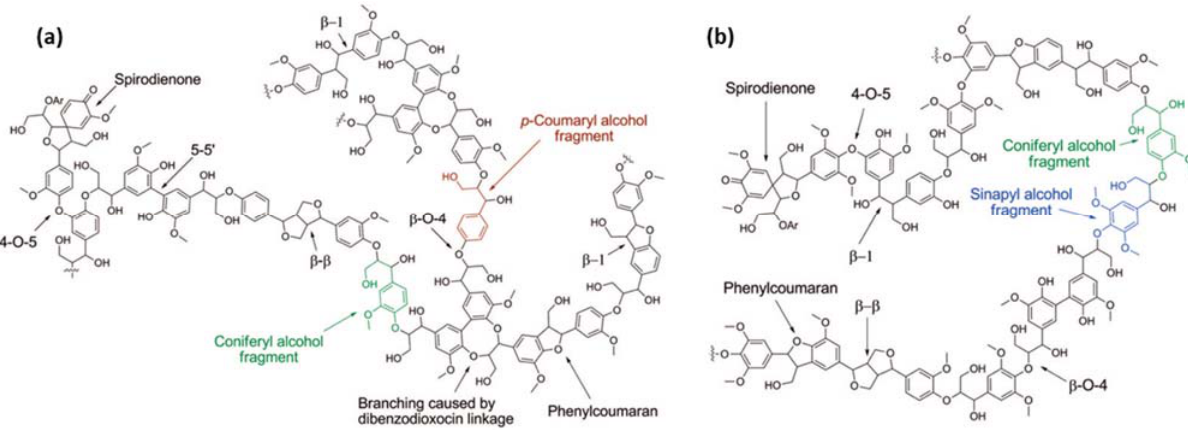
Figure 2. Schematic representation of ( a ) a softwood lignin structure consisting of repeated H (highlighted in red) and G (highlighted in green) unites and ( b ) a hardwood lignin structure consisting of repeated S (highlighted in blue) and G units (reproduced from Ref. [2] with permission from the American Chemical Society).